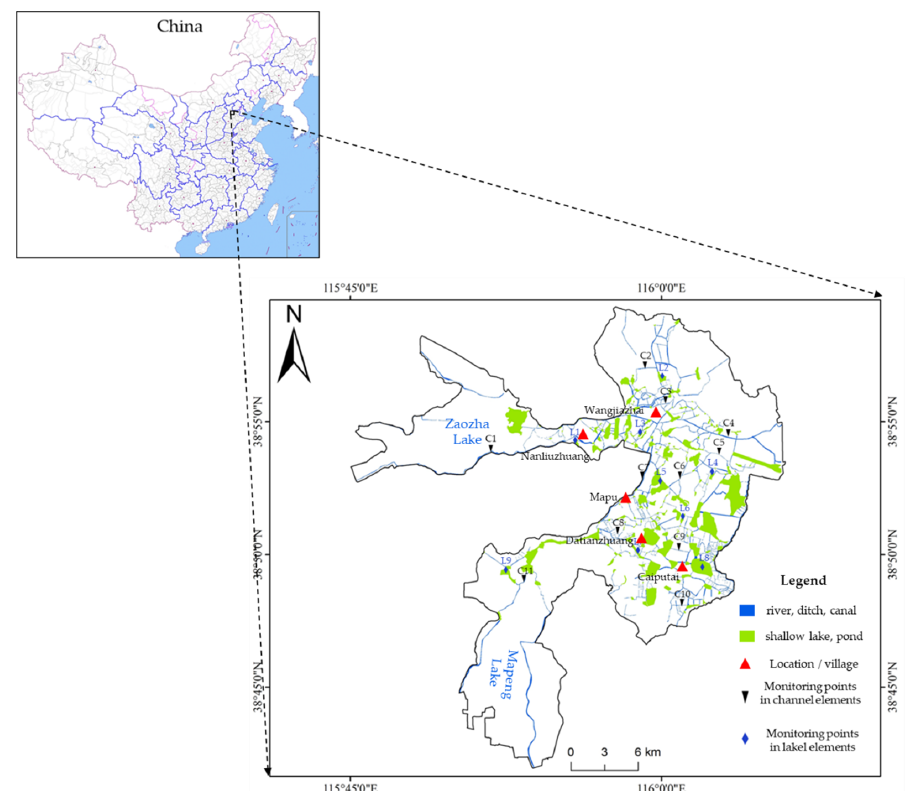
Figure 4. Location of the Baiyangdian Wetland and the study area.